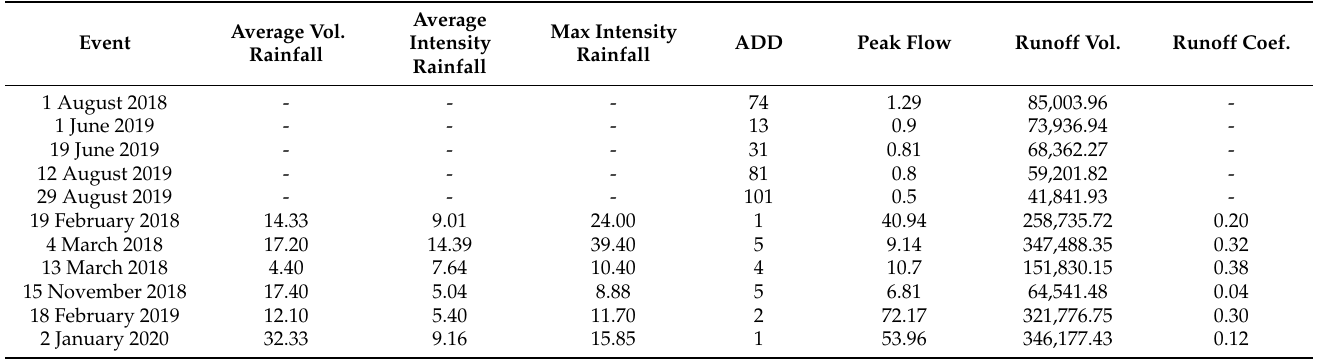
Table 2. Rainfall and Runoff characteristics for event